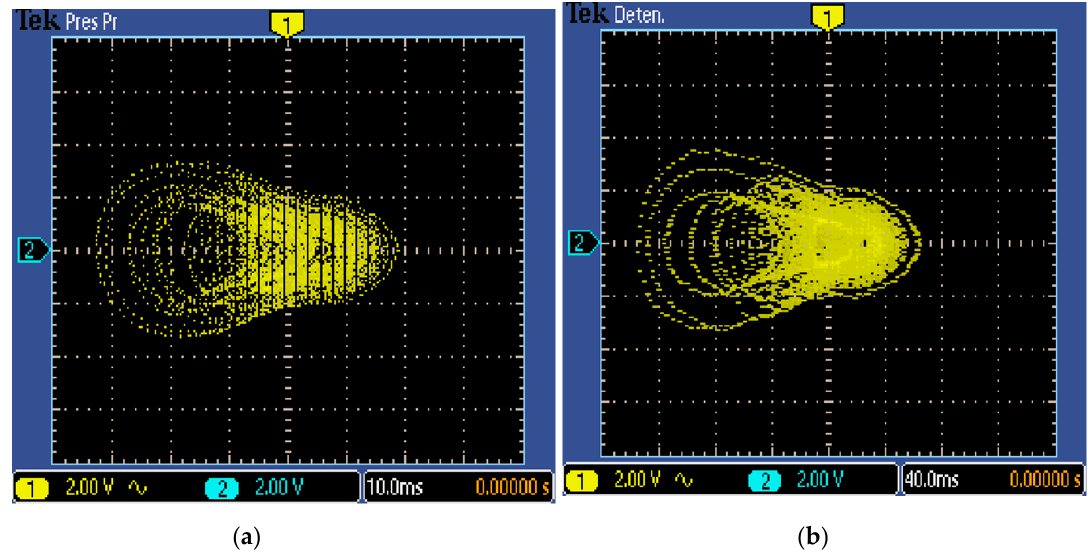
Figure 12. Oscilloscope views in the x - z plane (2v / div) of the new chaotic System (2) implemented in FPGA and with: ( a ) Forward-Euler with h = 0.001 and ( b ) fourth-order Runge-Kutta with h = 0.01.